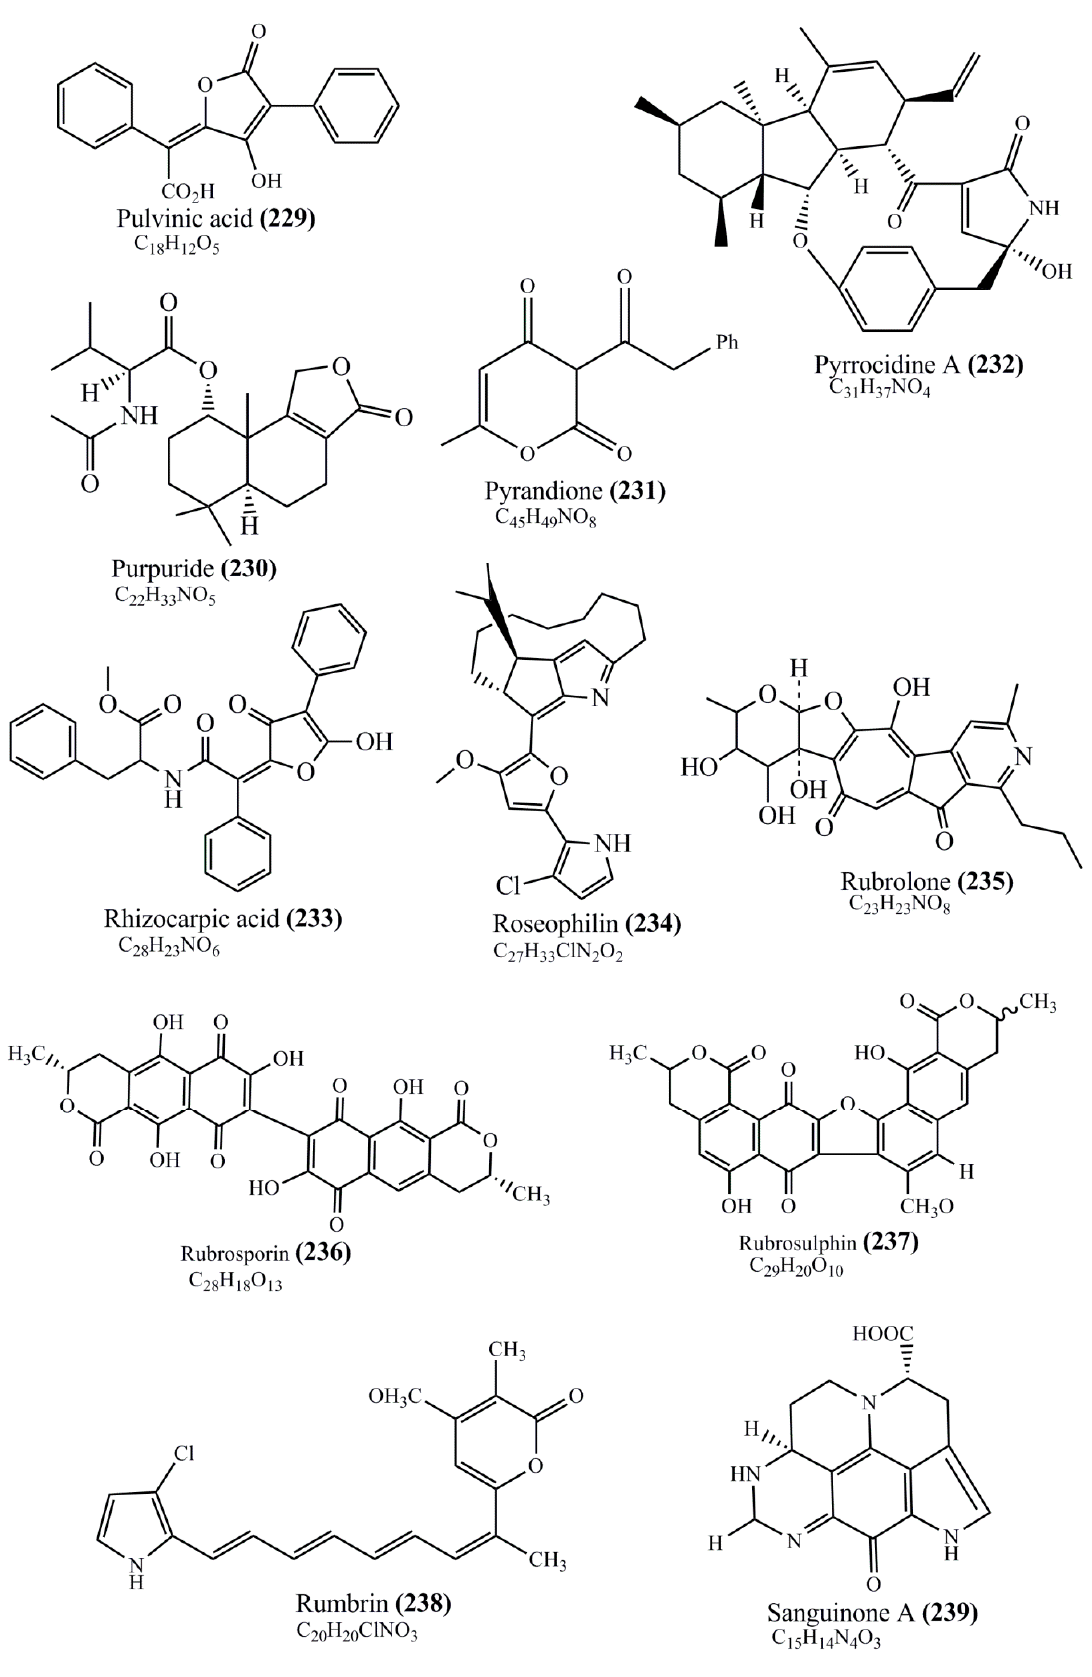
Figure 1. Figure 1. Continued.